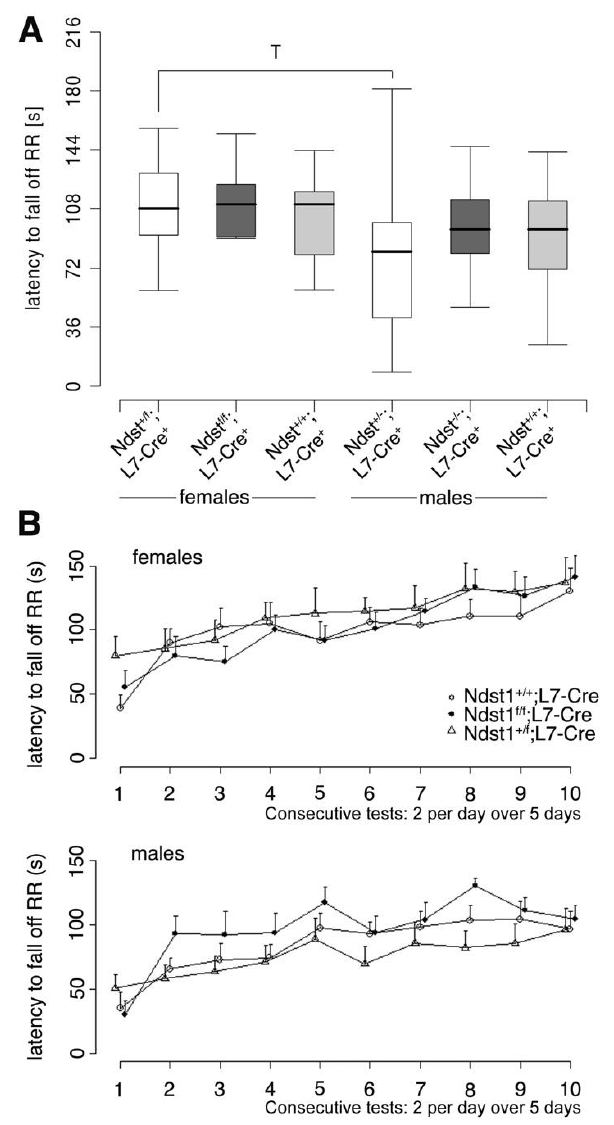
Figure 4. Locomotor abilities and balance are normal in Ndst1 mutant mice. ( A ) Latencies to fall off the Rotarod were measured in 10 trials on 5 consecutive days. ( B ) Repeated-measures using ANOVA with genotype and sex as independent measures and trials as repeated factors revealed significant sex differences (F(1580) = 29.8; p < 0.001) and an overall improvement over trials (F(9580) = 10.9; p < 0.001) but no effect of genotype. f Ndst1 +/f ;L7-Cre + n = 11, f Ndst1 f/f ;L7-Cre + n = 13, f Ndst1 +/+ ;L7-Cre + n = 9, m Ndst1 +/f ;L7-Cre + n = 13, m Ndst1 f/f ;L7-Cre + n = 9, m Ndst1 +/+ ;L7-Cre + n = 12.